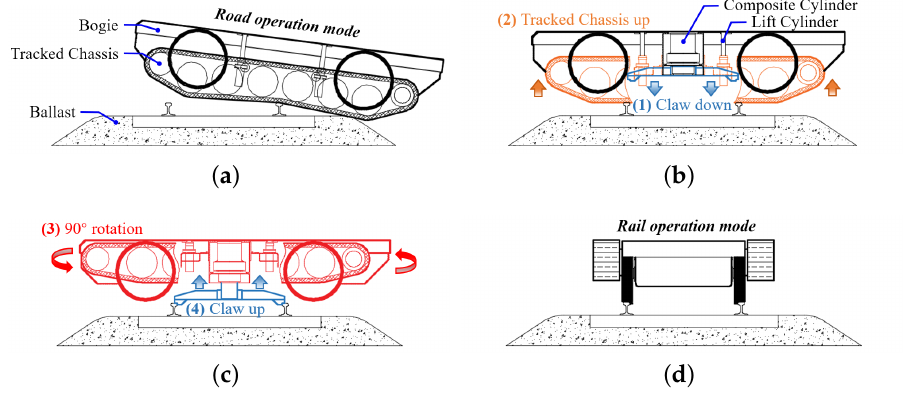
Figure 2. Operation mode switching process ( a ) Climbing process ( b ) Lifting process ( c ) Rotating process ( d ) Switching complete.